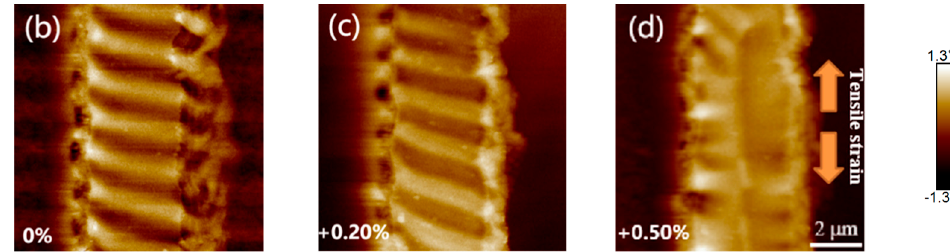
Figure 6. MFM images of micro-domain structure of 5 µm linewidth CoFeB thin films under different strain conditions: ( a ) 0.20% compressive strain, ( b ) no strain, ( c ) 0.20% tensile strain, ( d ) 0.50% tensile strain.